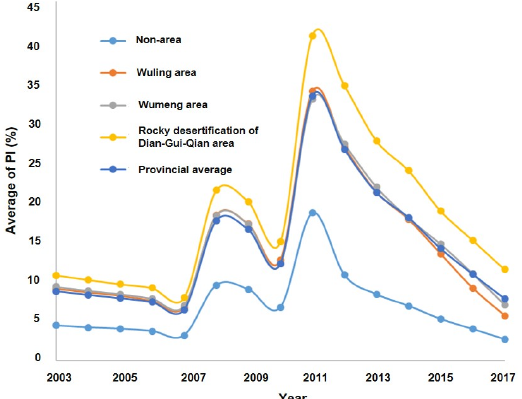
Figure 5. Average PI between the three continuously poverty-stricken areas and the nonpoverty- stricken areas from 2003 to 2017.